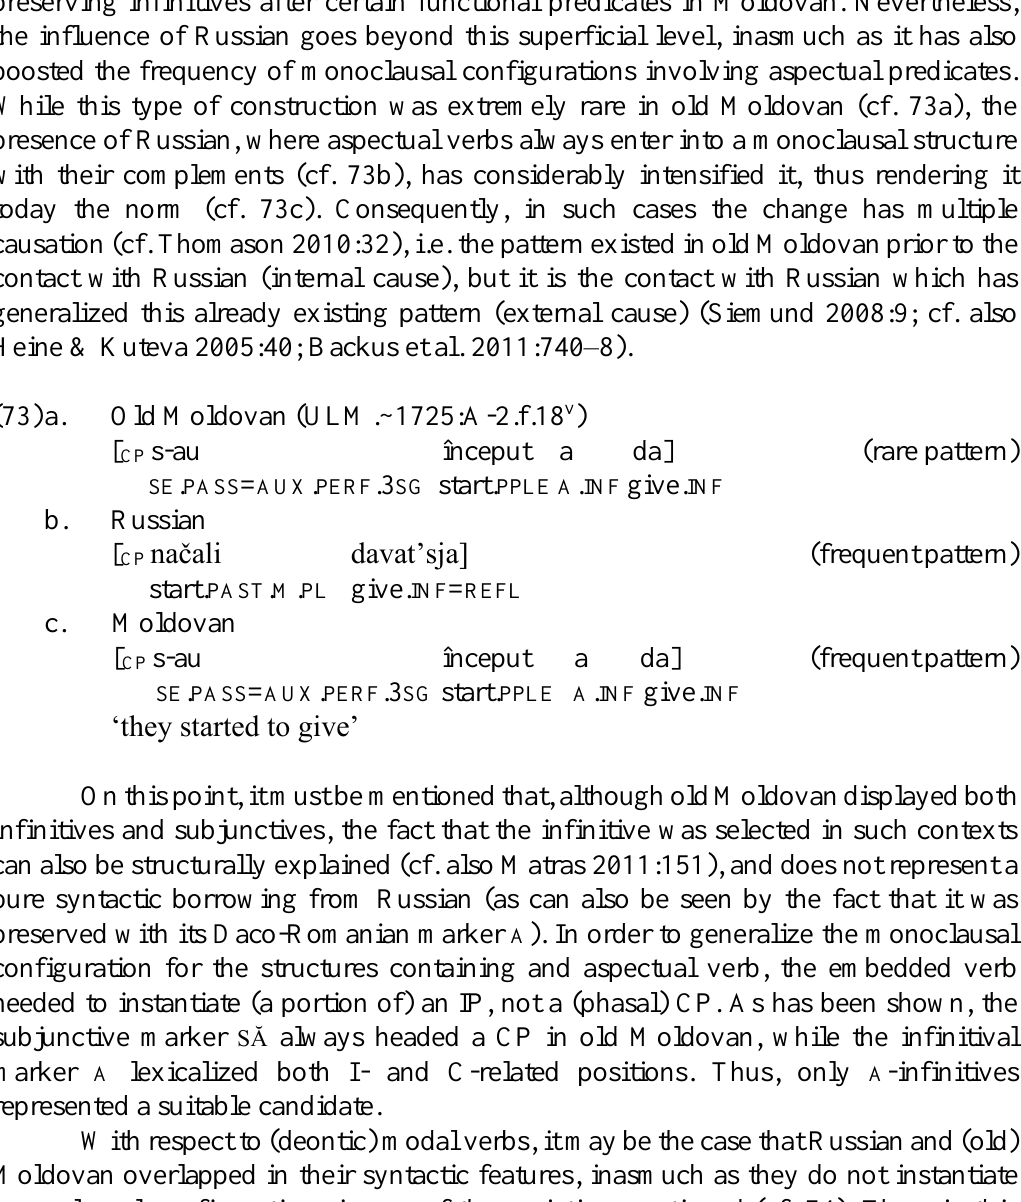
must can want try succeed start finish SĂ . SBJ do. SBJ . IND .3 SG IND . IND .1 SG IND . IND .1 SG IND .1 SG IND .1 SG 1 SG 1 SG 1